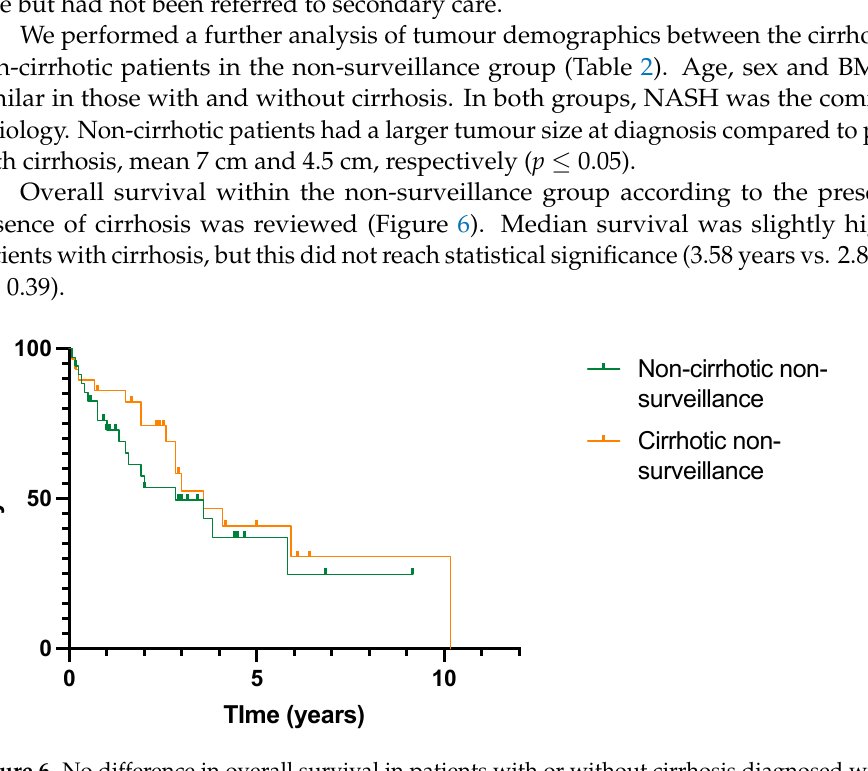
Figure 5. No difference in overall survival between patients diagnosed with HCC in and outside surveillance. All-cause mortality. p = 0.41 (log rank Mantel–Cox test).